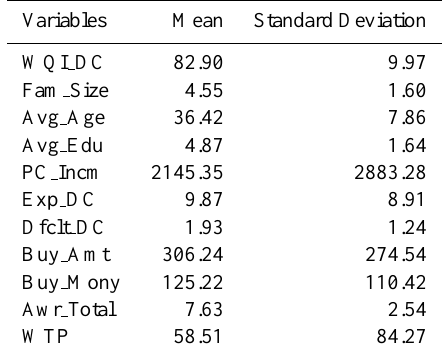
Table 7. Variables statictics for multiple regression.